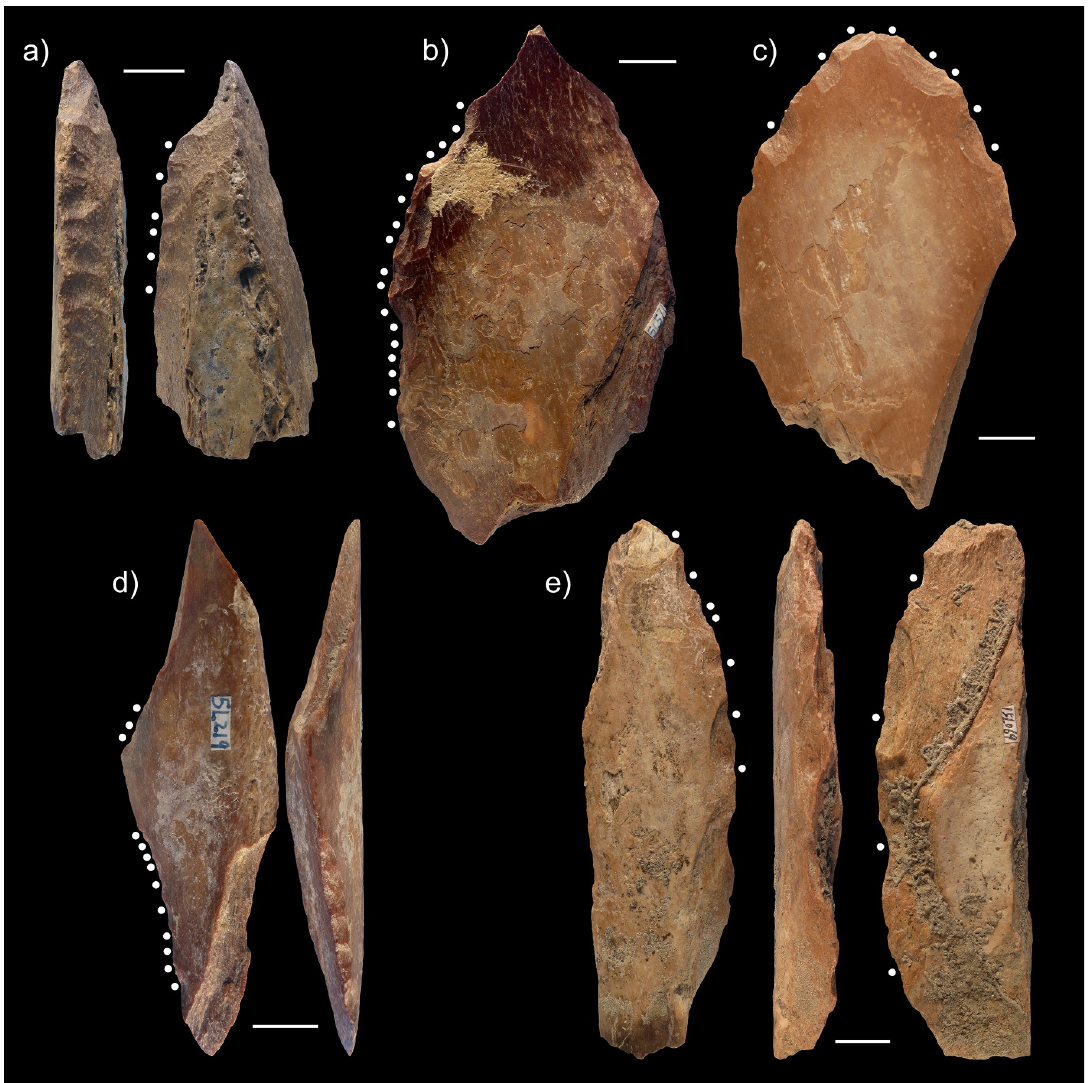
Fig 8. Close-up views of a sample of diaphyseal fragments bearing flake scars from Lingjing, layer 11. Dots indicate the location of flake scars produced by direct percussion. Notice the variability in the flaking pattern and distribution. Scales = 1cm.